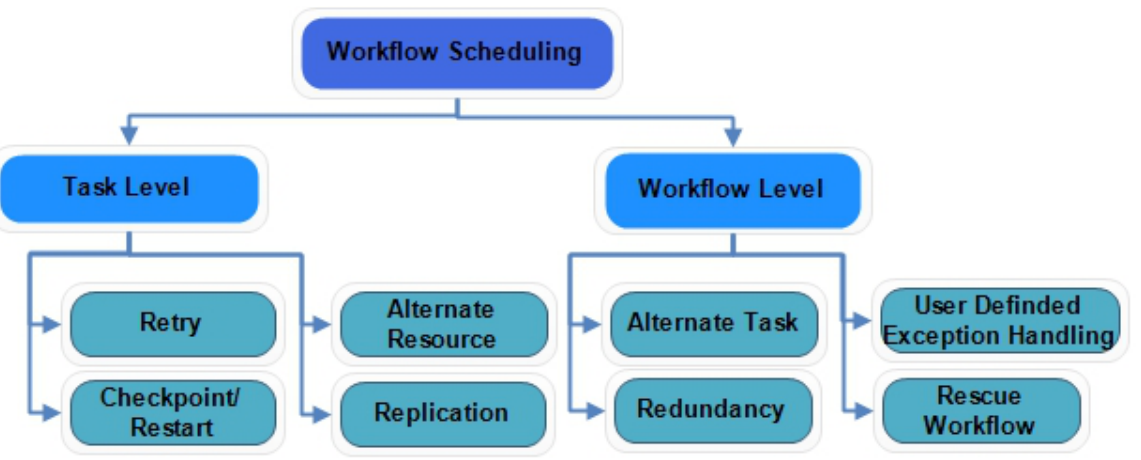
Figure 3. Components of workflow scheduling